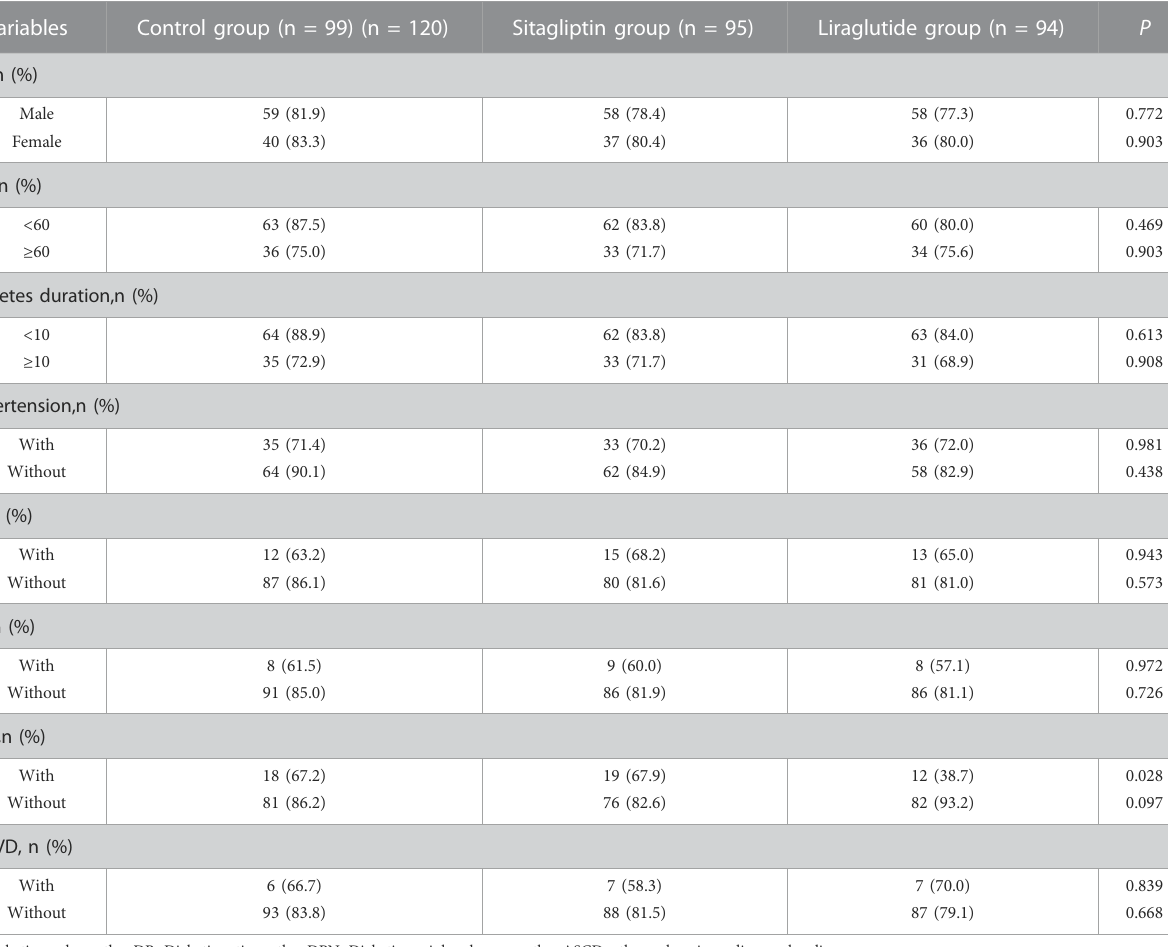
TABLE 3 Subgroup analyses for adequate bowel preparation.